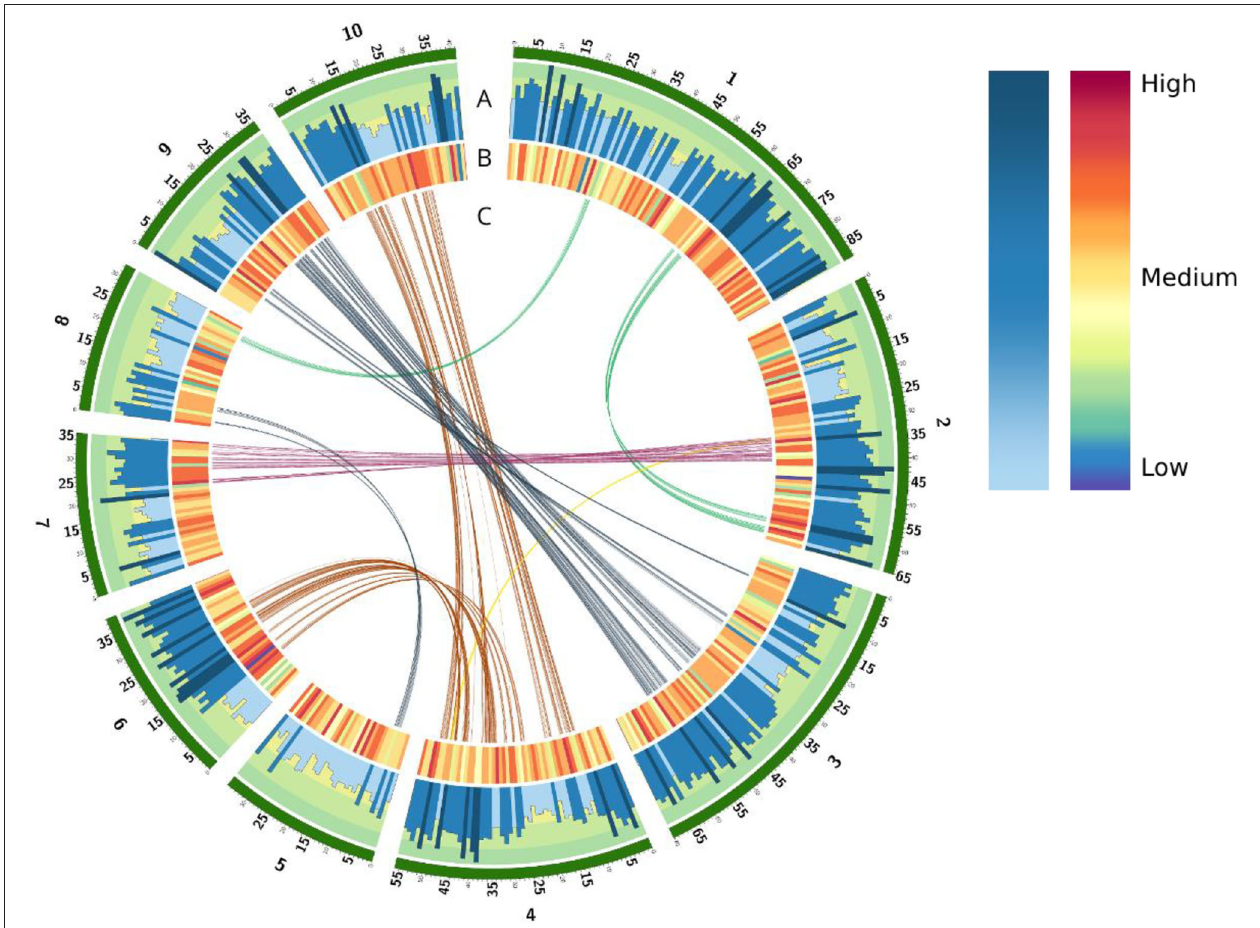
FIGURE 1 | Overview of genomic elements annotated in the CC 01-1940 assembly. In green color are the 10 assembled pseudo-chromosomes. (A) Histogram of genes for each chromosome. Each bar represents the total of genes in a windows size of 1mb. (B) Density of TEs in a windows size of 1mb. (C) Duplicate regions in the genome related to whole genome duplication (WGD)